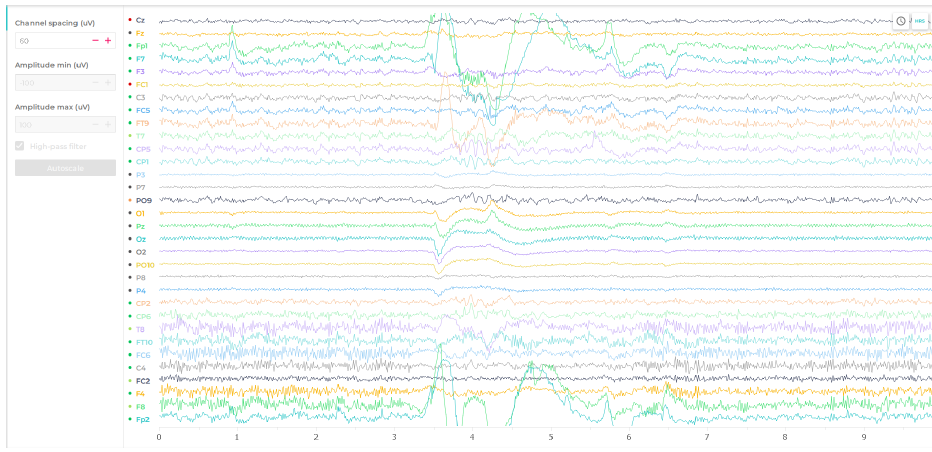
Figure 16. Signal analysis dashboard in EmotivPRO